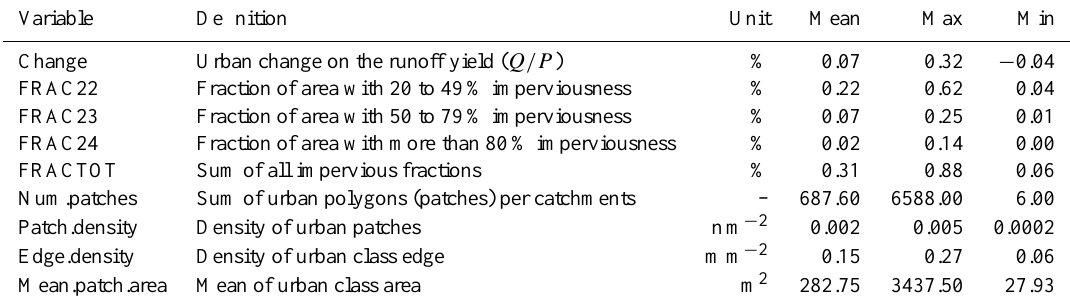
Table 1. Summary of variables used in this study. Variable